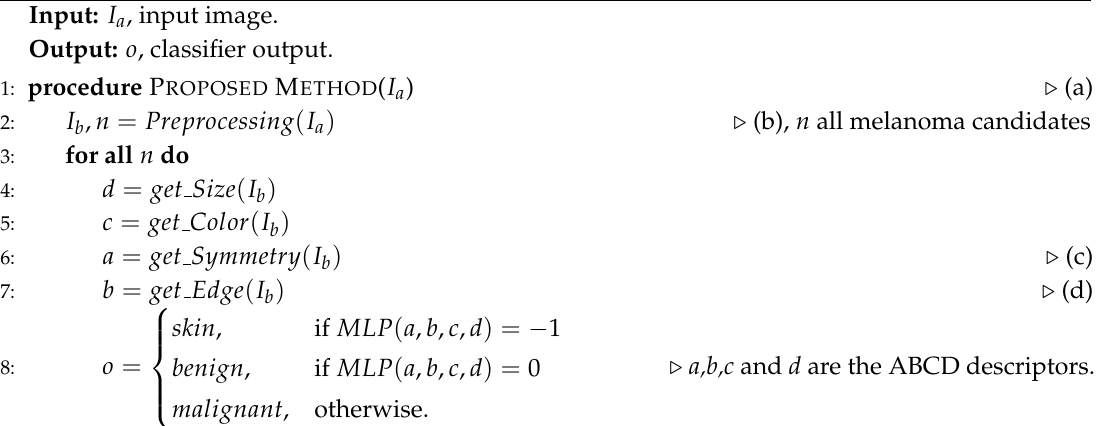
Algorithm 1 Stages of the proposed method, showing lines 1–8, and annotated with letters (a)–(d), corresponding to the images in Figure